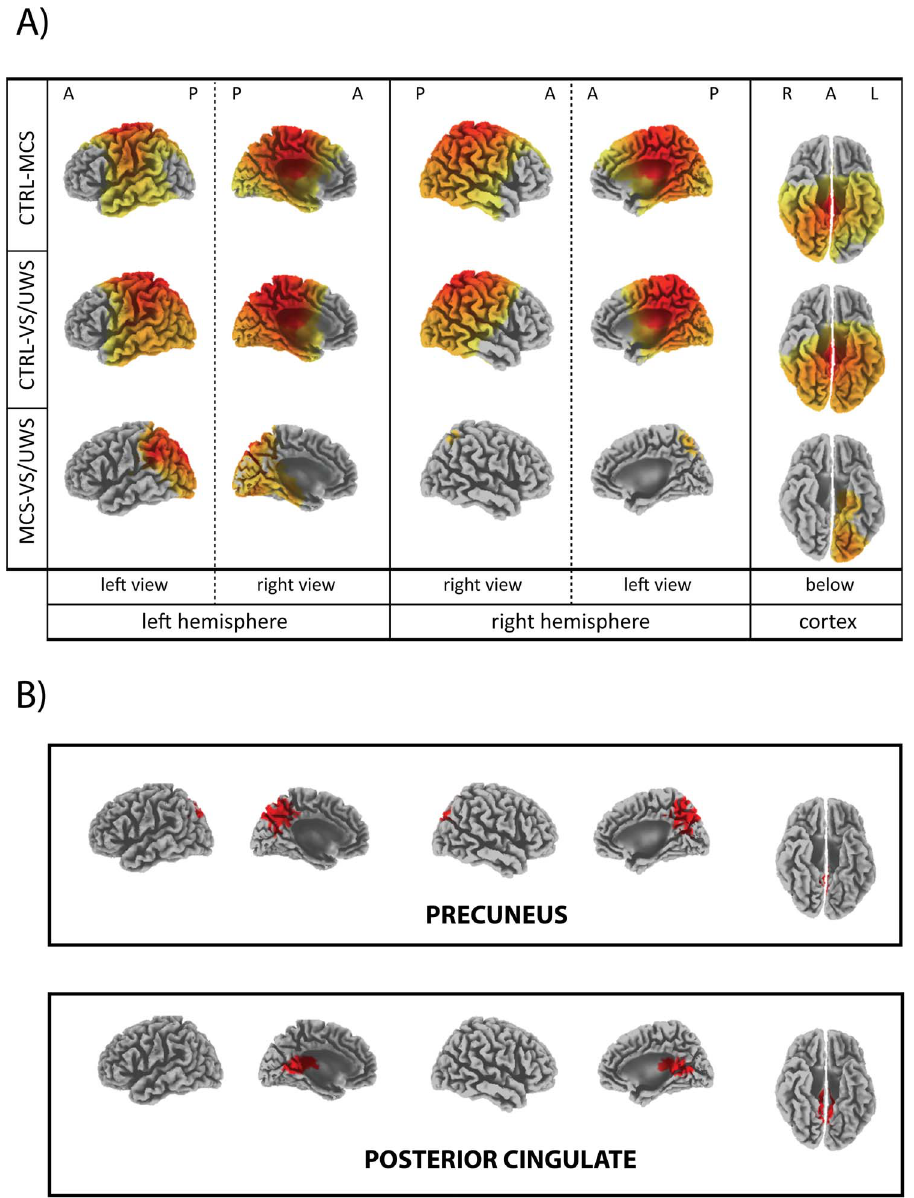
Figure 5. Between-groups post-hocs (CTRL-MCS, CTRL-VS/UWS and MCS-VS/UWS) for low-beta current densities. Results of between- groups post-hocs for low-beta current densities are depicted in panel A. For each group, subject, trial and voxel, the current density value was normalized referred to the full-band current density value of the voxel and then log-transformed. Only voxels with a t-value corresponding to a p- value less than 0.05 are depicted. Yellow to red tones refer to progressively higher t-values: for the CTRL-MCS post-hoc, 4737 voxels had a p , 0.001 on a total of 4774 significant voxels; for the CTRL-VS/UWS post-hoc, 4461 voxels had a p , 0.001 on a total of 4493 significant voxels; for the MCS-VS/UWS post-hoc, 1055 voxels had a p , 0.001 on a total of 1185 significant voxels. Throughout the figure, A denotes the anterior part of the cortex, P the posterior part, R the right hemisphere and L the left one. The CTRL group shows a higher current density on the midline centro-posterior cortices of both hemispheres compared to both MCS and VS/UWS groups. In particular, PCC/PCu (together with anterior cingulate cortex and paracentral lobule) appears as the cortical region where the highest differences are detected in the comparisons between CTRL and DOC, but also between MCS and VS/UWS. Furthermore, CTRL subjects show a higher cortical activity upon the dorsolateral centro-posterior regions of both hemispheres when compared to DOC patients, with the exception of the temporo-parieto-occipital junction (TPOJ) which has current density levels comparable to those of MCS patients. Note that MCS patients show a higher cortical activity on both temporo-parietal junction to VS/UWS. In panel B, the localization of both the precuneus and the posterior cingulate cortex (highlighted in red) are presented as a support to the interpretation of the images presented in panel A. doi:10.1371/journal.pone.0093252.g005 tions in low- and high-alpha bands have already achieved Then, the low-beta band follows, depending on the level of its functional levels which are consistent with the condition of ability to differential diagnosis. As regards this latter frequency normality. band, however, MCS subjects show significantly lower levels of